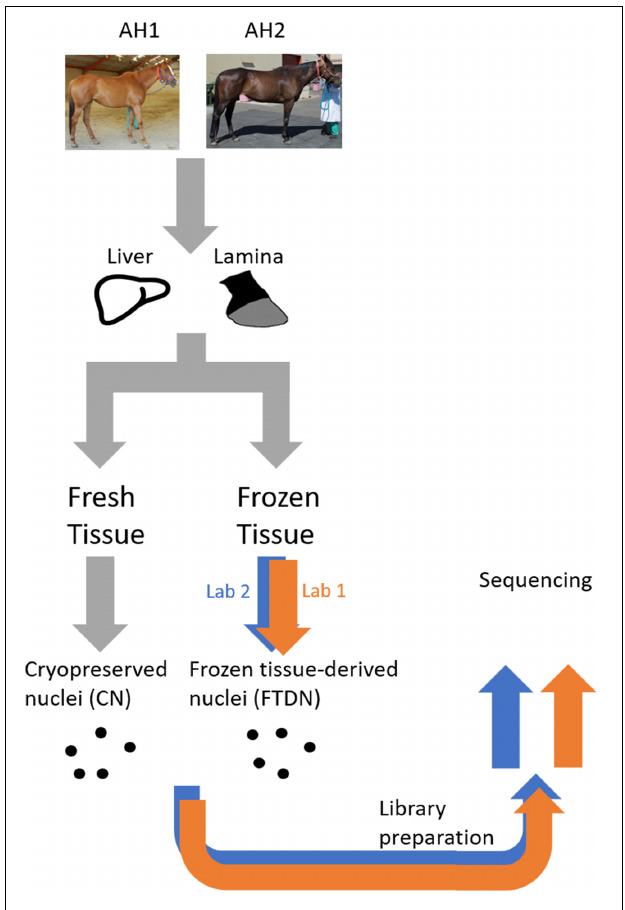
FIGURE 1 | A schematic of the experimental design. All samples were prepared at UC Davis prior to shipment to the core laboratories. Samples used were obtained from an equine biobank of two horses (AH1 and AH2), as previously described (Burns et al.,